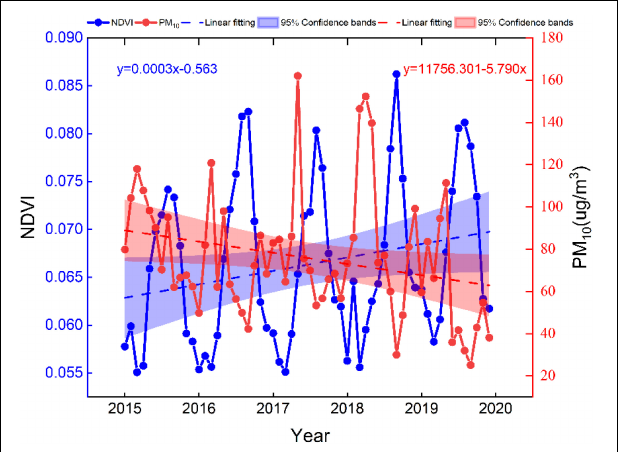
FIGURE 9 | Line chart of NDVI and PM 10 of Alxa League from 2015 to 2019.